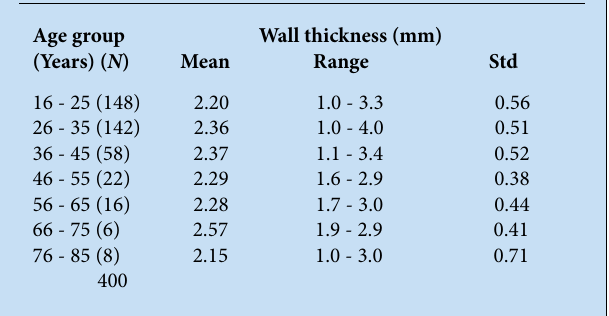
Fig. 1. Longitudinal US image showing site of measurement of gallbladder wall thickness (arrows). Table I. Age distribution of mean gallbladder wall thickness in the study population